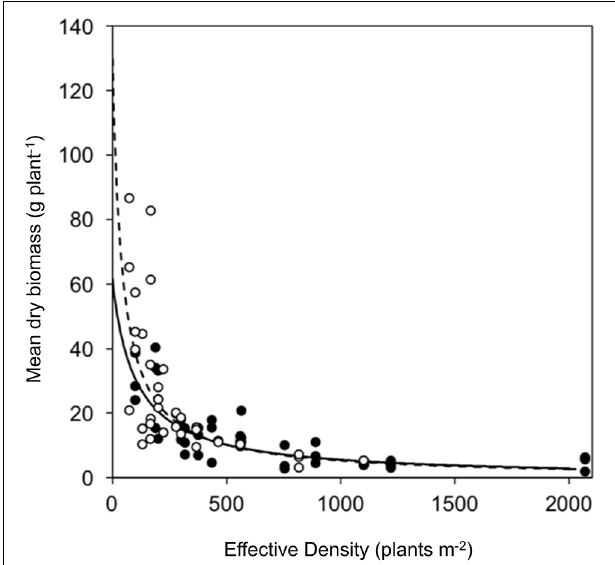
FIGURE 5 | Vegetative growth of a glyphosate sensitive and resistant seed family in response surface competition experiment. Symbols represent mean biomass of resistant (black) and susceptible (white) phenotypes from replicate planting boxes at each effective density. Curves show fitted hyperbolic models for resistant (solid) and the susceptible (dashed) phenotypes.